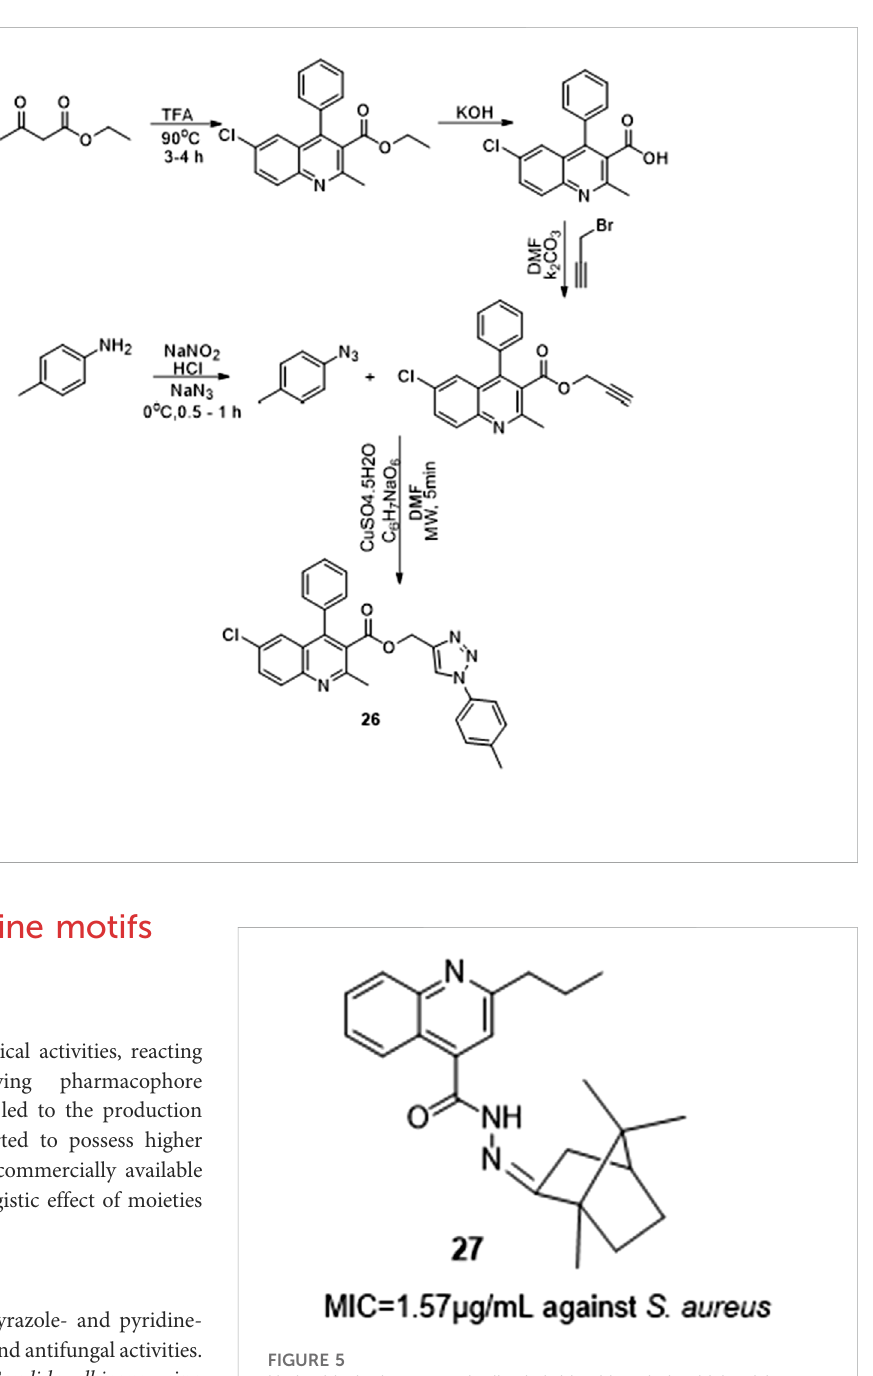
FIGURE 5 Hydrazide-hydrazone-quinoline hybrids with antimicrobial